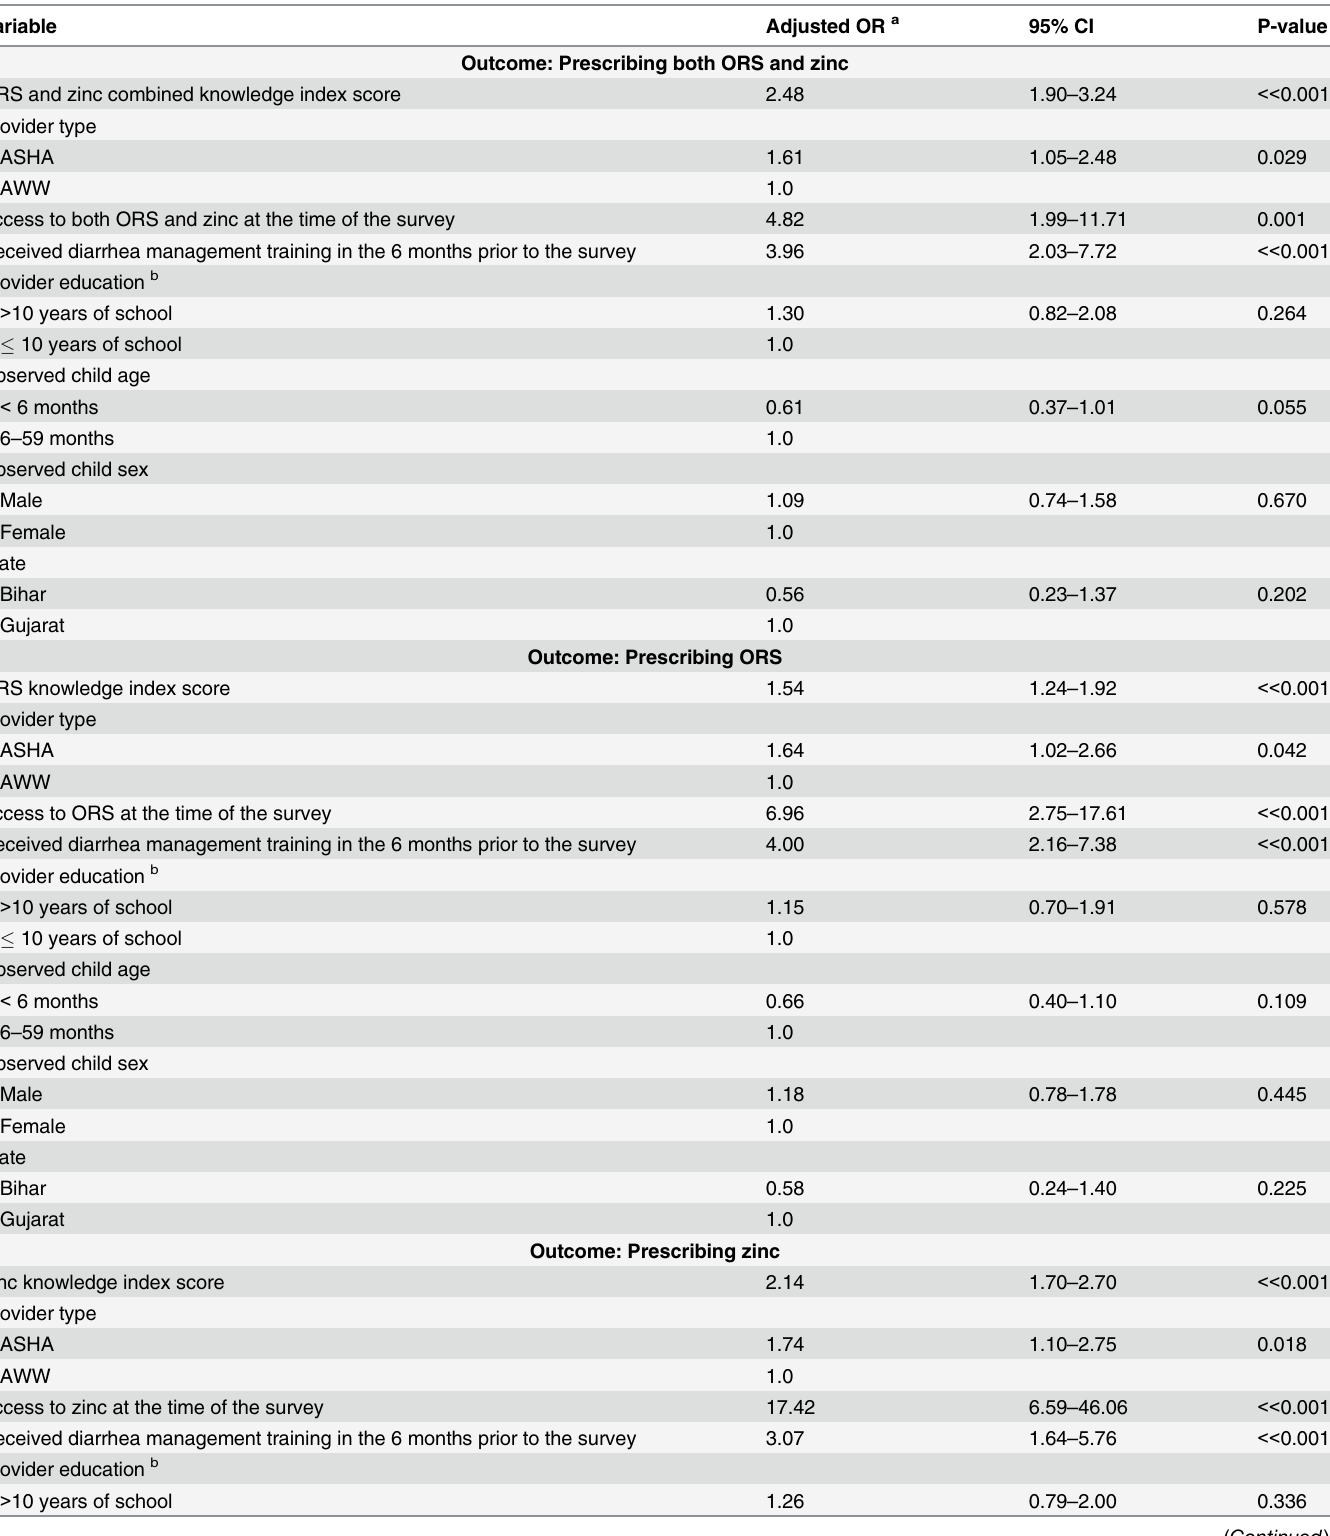
Table 4. Factors associated with prescribing among public sector ASHAs and